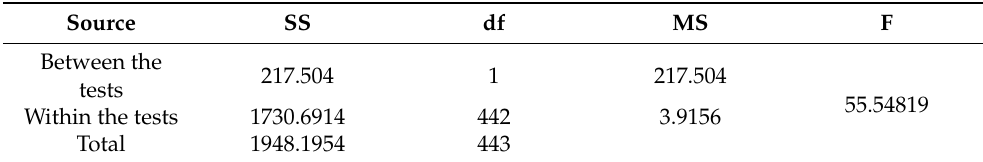
Table 8. Result details (one-way ANOVA) for diagnostic and knowledge tests. SS: Sum of Squares, df: degrees of freedom, MS: Mean